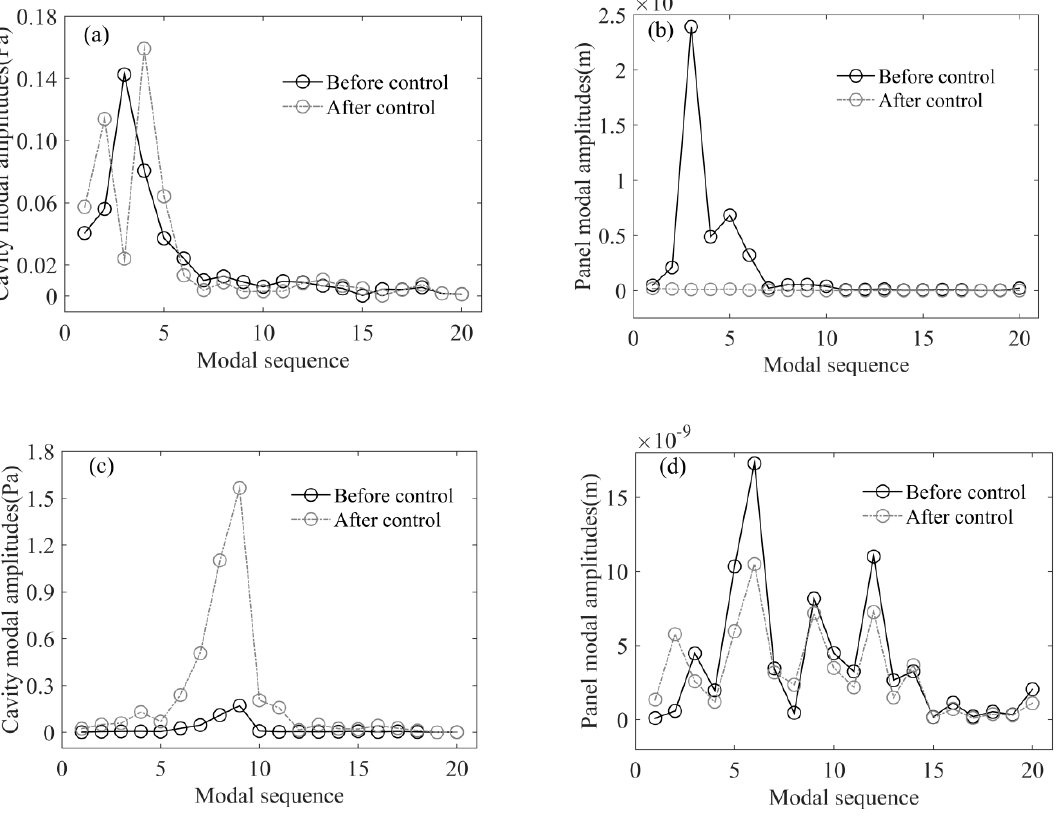
Figure 8. Modal amplitudes of the first twenty modes before and after control when f = 203 Hz (Case 4), f = 425 Hz (Case 5). ( a , c ) ( a ) Cavity modes for Cases 4, ( c ) Cavity modes for Cases 5. ( b , d ) ( b ) Base plate B modes for Cases 4, ( d ) Base plate B modes for Cases 5.